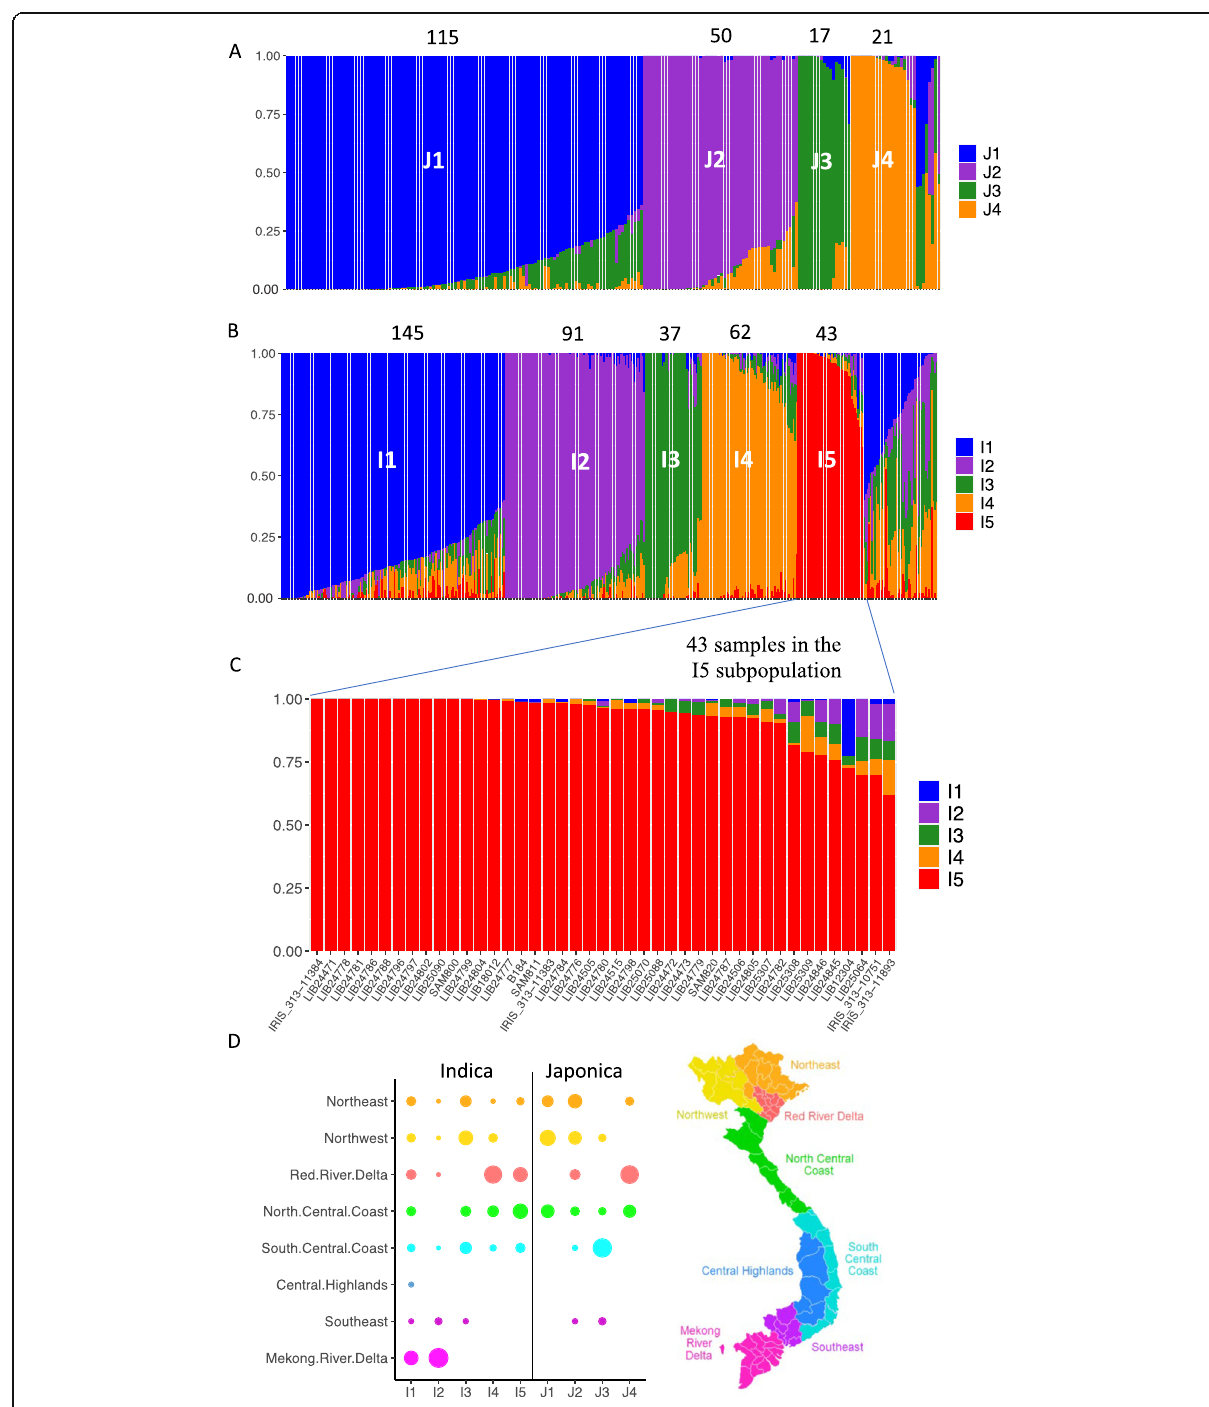
Fig. 1 Population structure and location of the Indica and Japonica subpopulations within Vietnam. a STRUCTURE results (mean of 10 replicates) at K = 4 for 211 Japonica subtypes. The cut off for inclusion in each subpopulation is 0.6. The number of samples in each subpopulation is shown above, a further 8 samples were classified as admixed. b STRUCTURE results (mean of 10 replicates) at K = 5 for 426 Indica subtypes. Each colour represents one subpopulation. Each accession is represented by a vertical bar and the length of each coloured segment in each bar represents the proportion contributed by each subpopulation. The cut off for inclusion in each subpopulation is 0.6. The number of samples in each subpopulation is shown above, a further 48 samples were classified as admixed. c STRUCTURE results for the I5 subpopulation expanded to show individual samples. d The proportion of each population originating from each of the 8 regions in Vietnam (based on a subset of 377 samples, 54% of Indica samples and 85% of Japonica